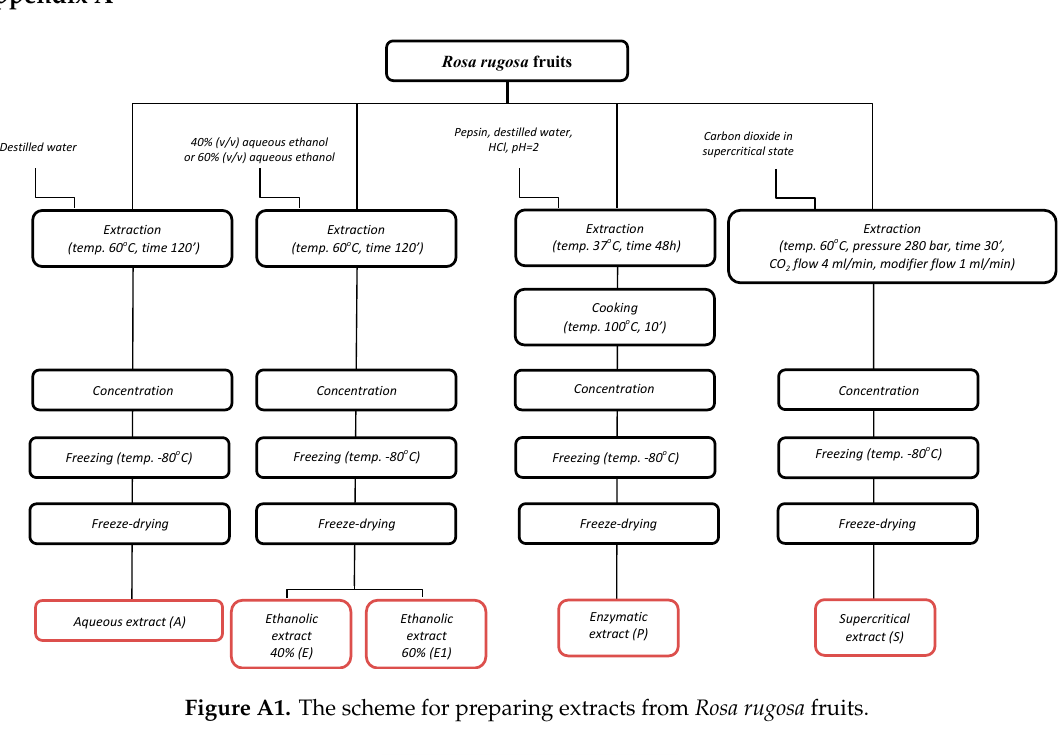
Figure A1. The scheme for preparing extracts from Rosa rugosa fruits.